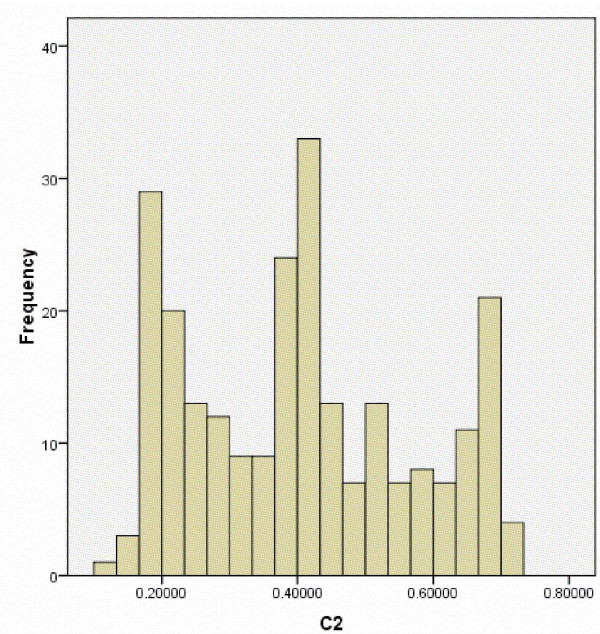
Histogram distribution of cluster 2 (C2) scores of Ashkenazi Jewish (AJ) individuals derived from ADMIXTURE analysis. The histogram distribution includes only those AJ subjects with low scores (< 0.475) on the Ashkenazi-specific cluster score (C3). The x-axis represents C2 scores and the y-axis represents the frequency.